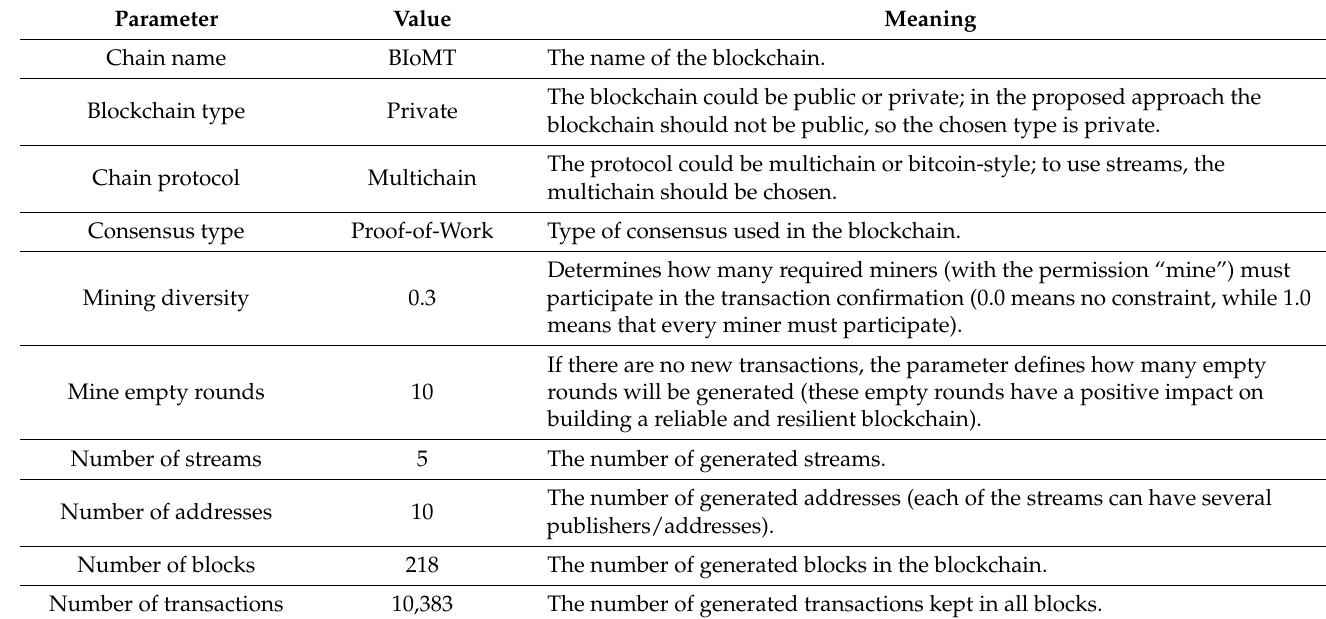
Table 2. Selected blockchain parameters used in the implementation of the BIoMT